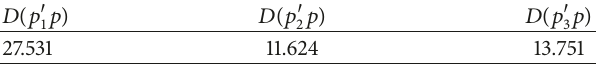
Table 7: Mahalanobis distance between RA and natural